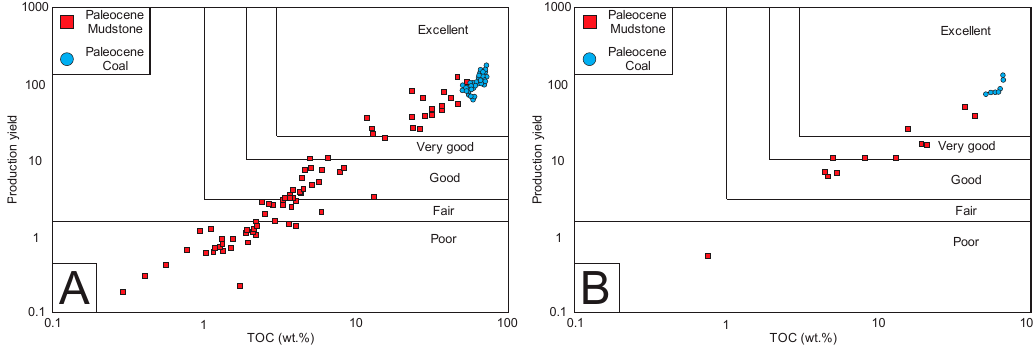
Figure 10. Cross plot of production yield versus TOC to exhibit the generating potential of the Cerrejón Formation in the ( A ) ANH-CARRETALITO-1 and ( B ) ANH-CAÑABOBA-1 wells.